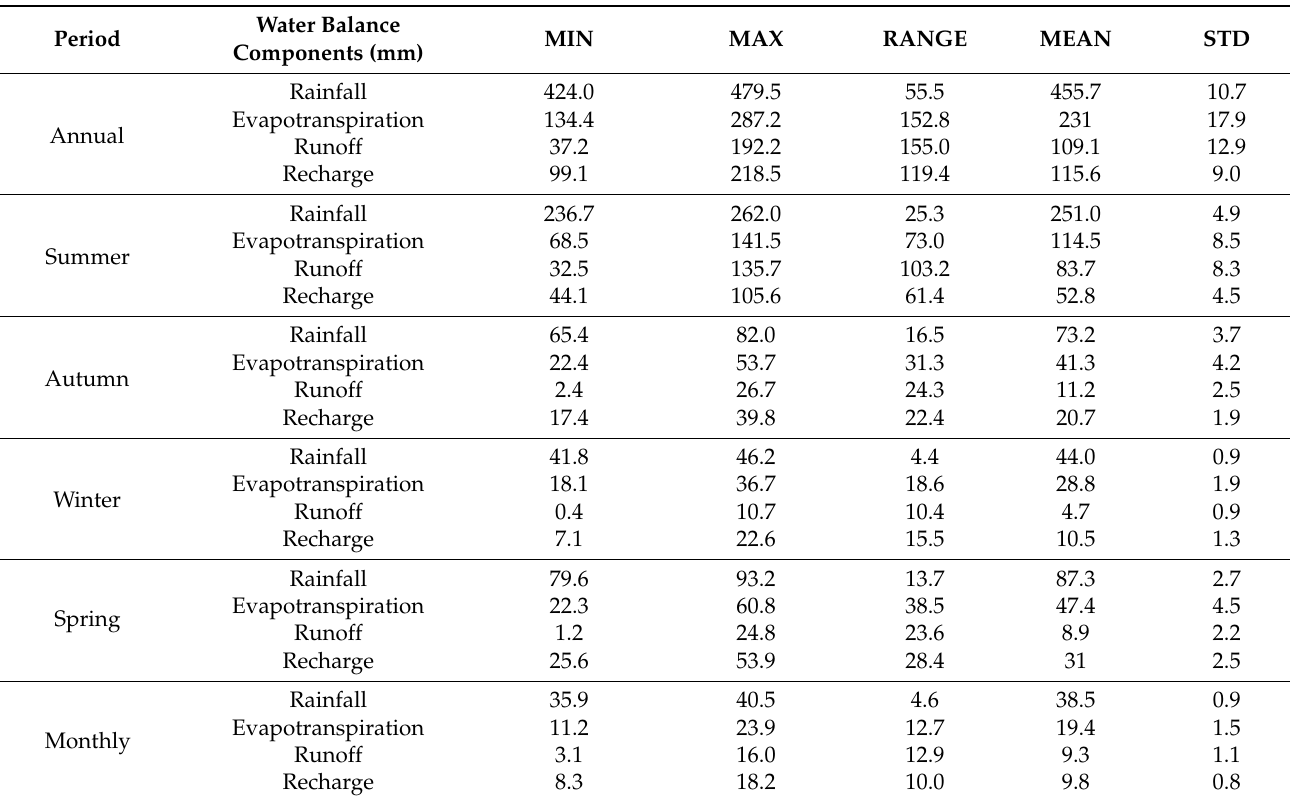
Table 2. Long-term annual, seasonal, and monthly simulated water balance components of the Khadir canal sub-division (2000–2019).